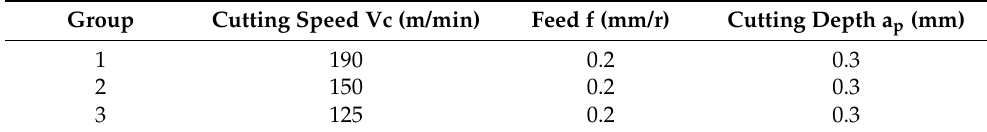
Table 3. Cutting Test Scheme.